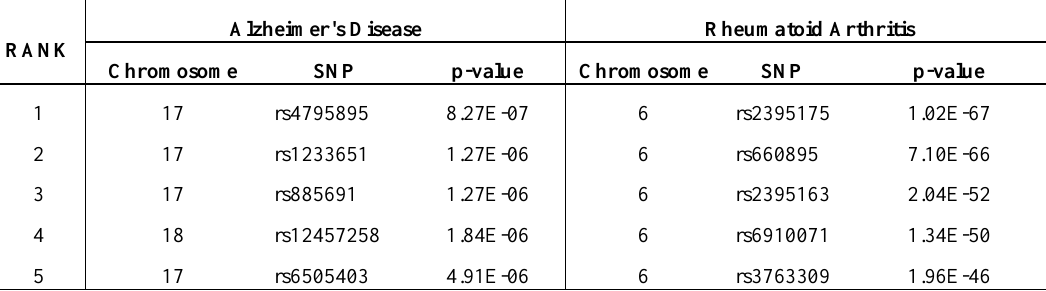
Table 9. Top 5 SNPs with the lowest p -values.